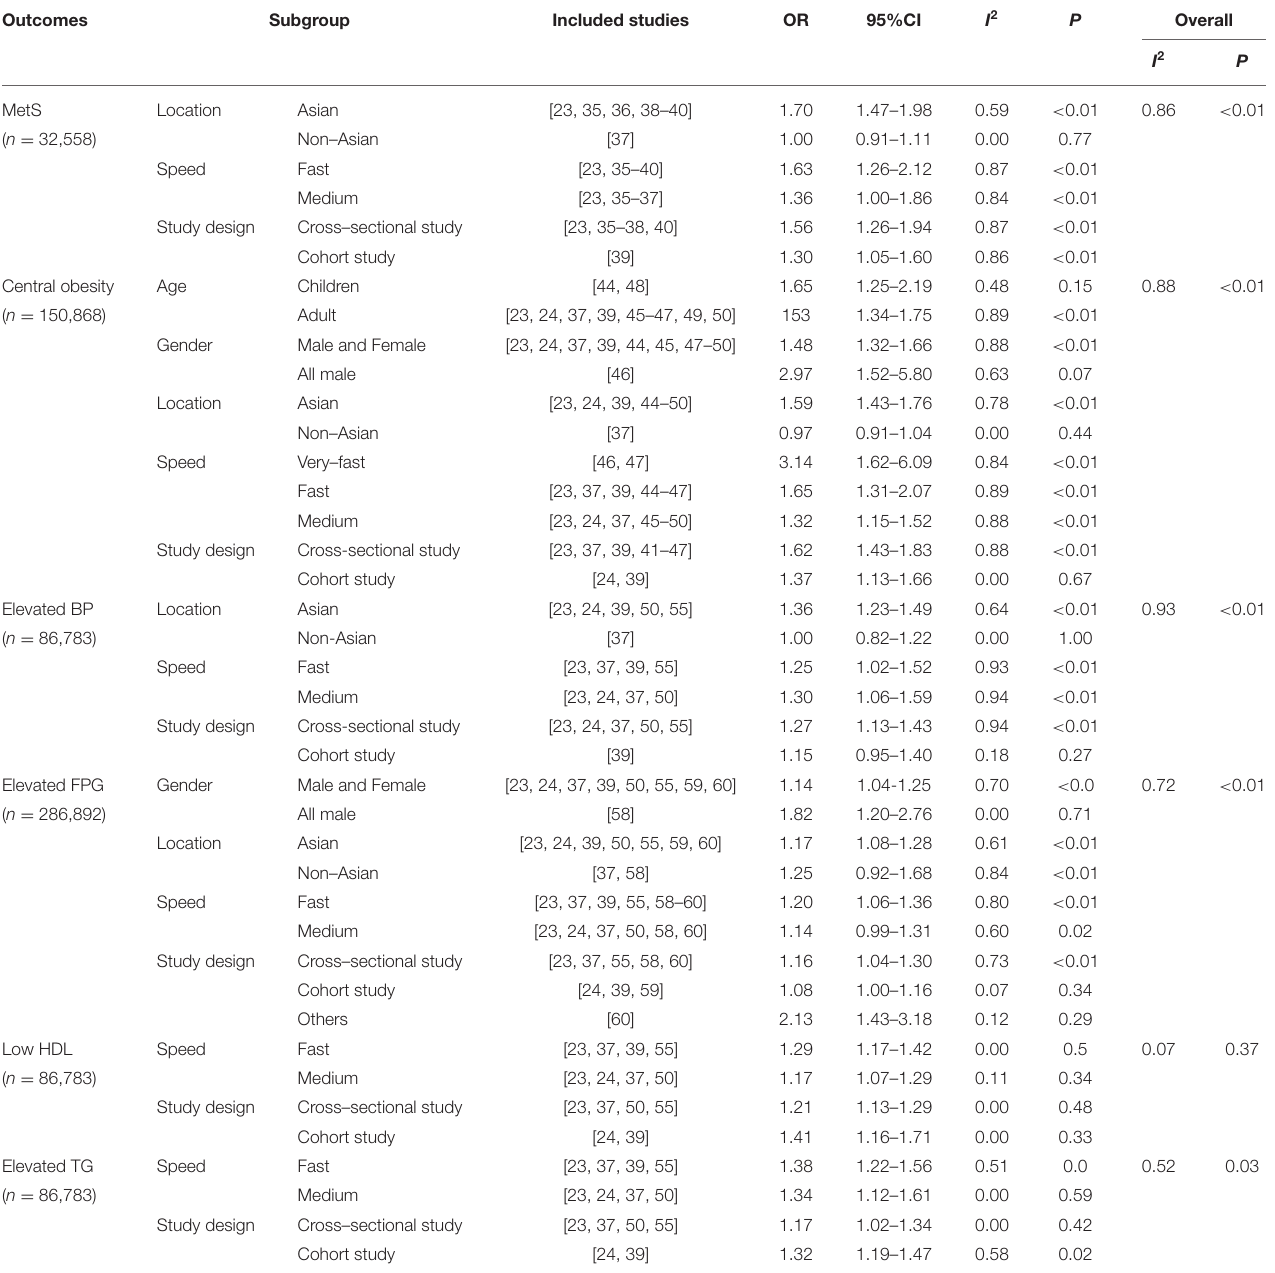
TABLE 2 | Subgroup analysis based on age, gender, location, eating speed, and study design. Outcomes